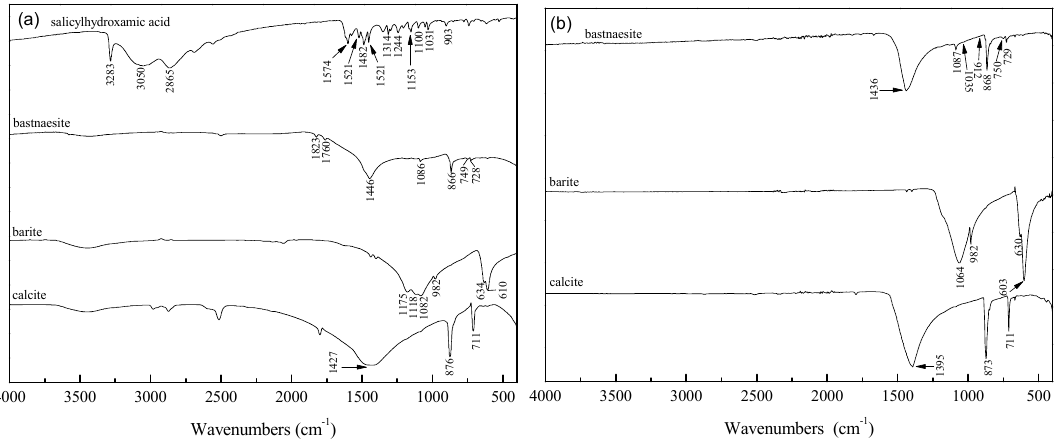
Figure 5. Fourier transform infrared (FT-IR) spectra of purified samples before ( a ) and after ( b ) treated with SHA at pH 7.5. Table 2. The bands corresponding to the relevant chemical bond in FT-IR spectra of the minerals. FTIR